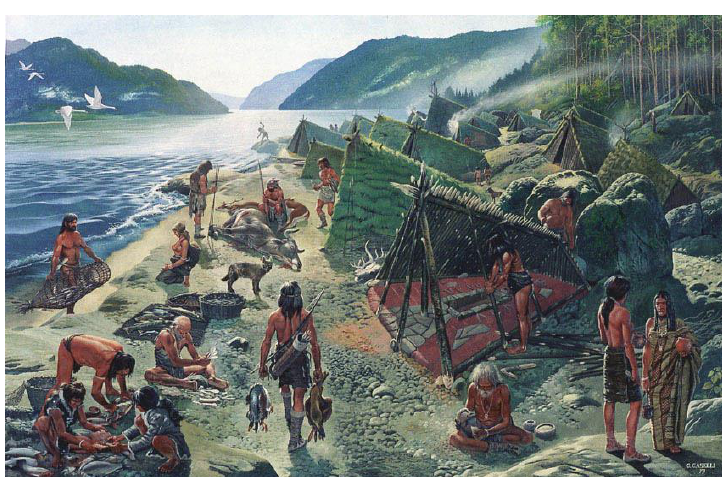
Figure 18. Lepenski Vir terrace above the Danube, originally, before immersion, during excavation on the spot [22]